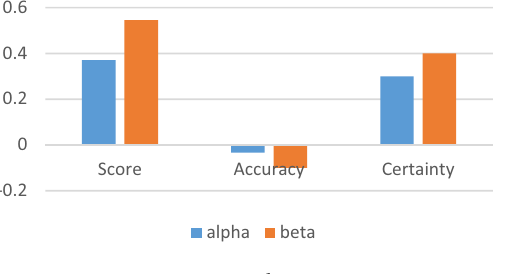
Figure 1. Score, accuracy, and